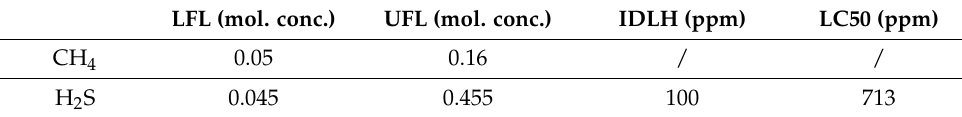
Table 1. CH4 and H2S flammability and toxicity